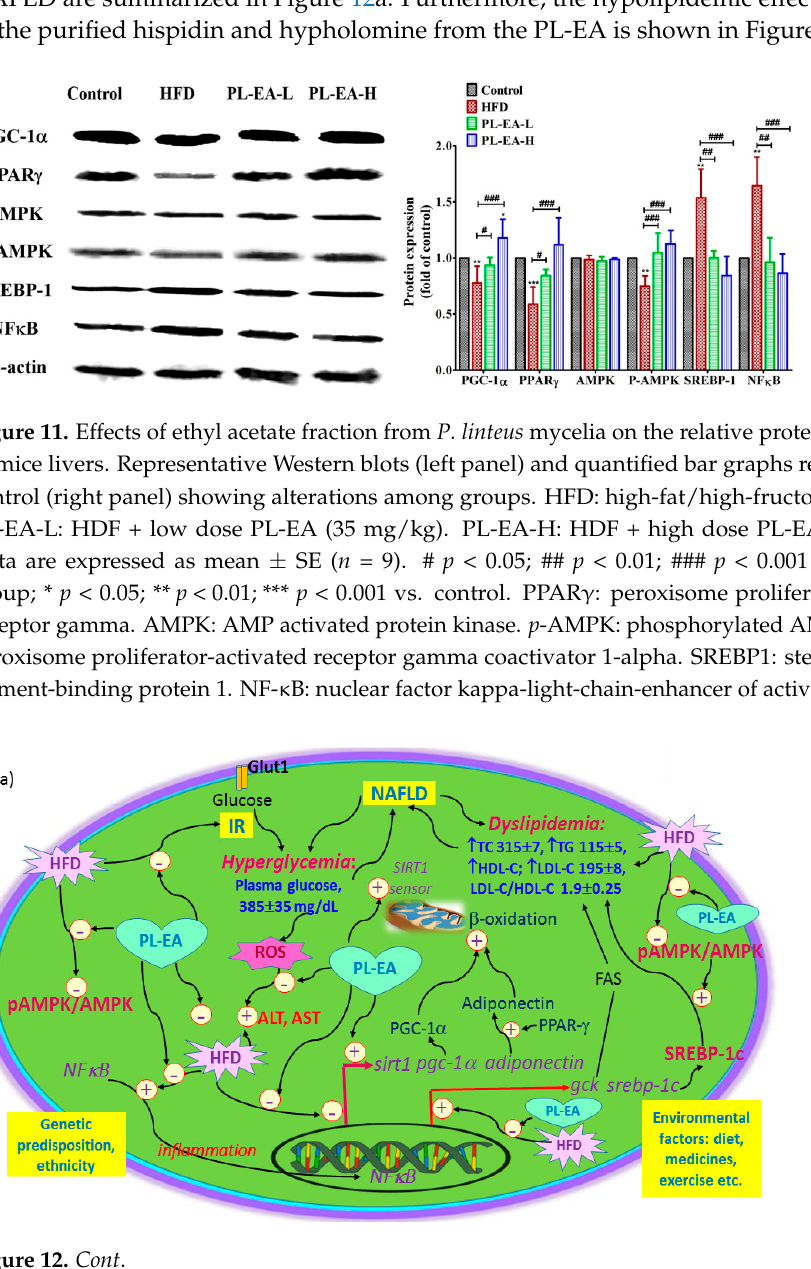
Figure 10. Effects of hispidin and hypholomine B isolated from the ethyl acetate fraction of P . linteus mycelia on the relative gene expression of HepG2 cell. Data are expressed as mean ± SE ( n = 3). *, **, and ***, p < 0.05, 0.01 and 0.001, respectively vs. the control; # , ## and ### , p < 0.05, 0.01 and 0.001, respectively vs. the O/P group. PGC1- α : peroxisome proliferator-activated receptor gamma coactivator 1-alpha; Sirt-1: NAD-dependent deacetylase sirtuin-1; SREBP-1c: sterol regulatory element-binding protein 1c.